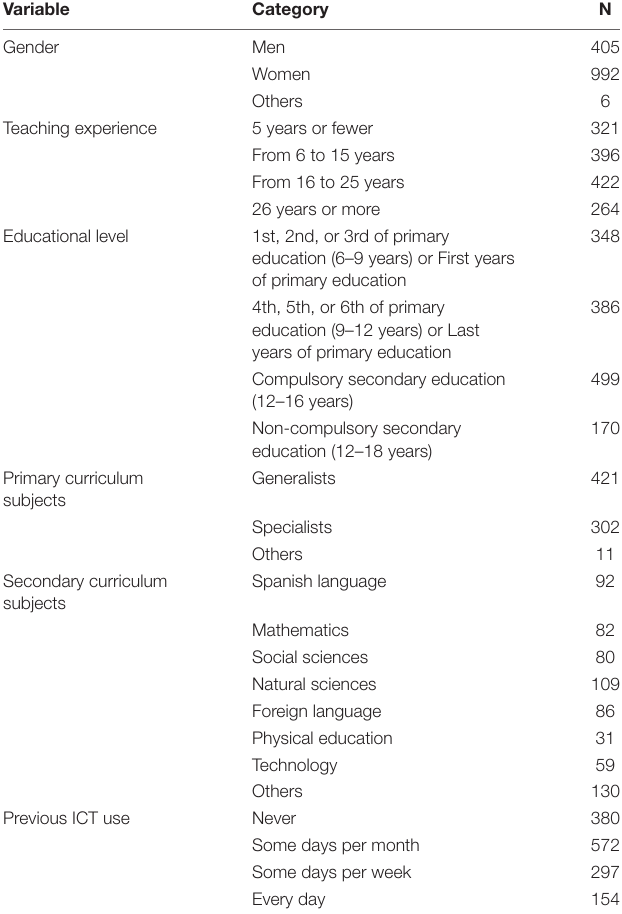
TABLE 2 | Characteristics of the sample and